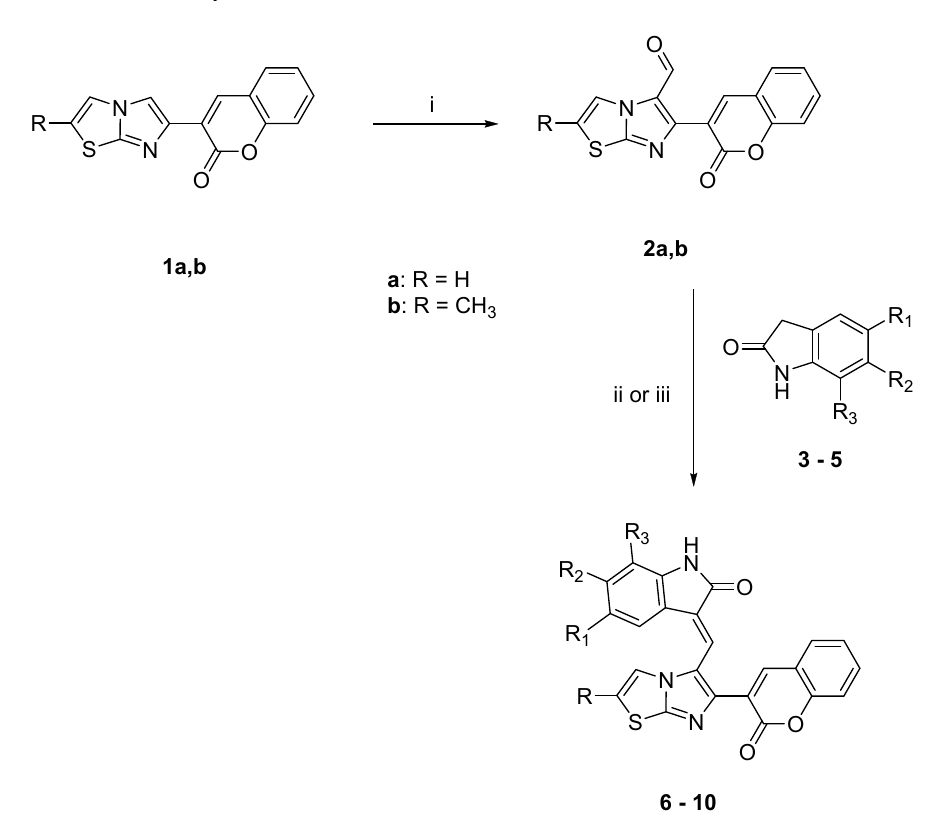
Scheme 1 Synthetic route for obtaining compounds 6 – 10 .